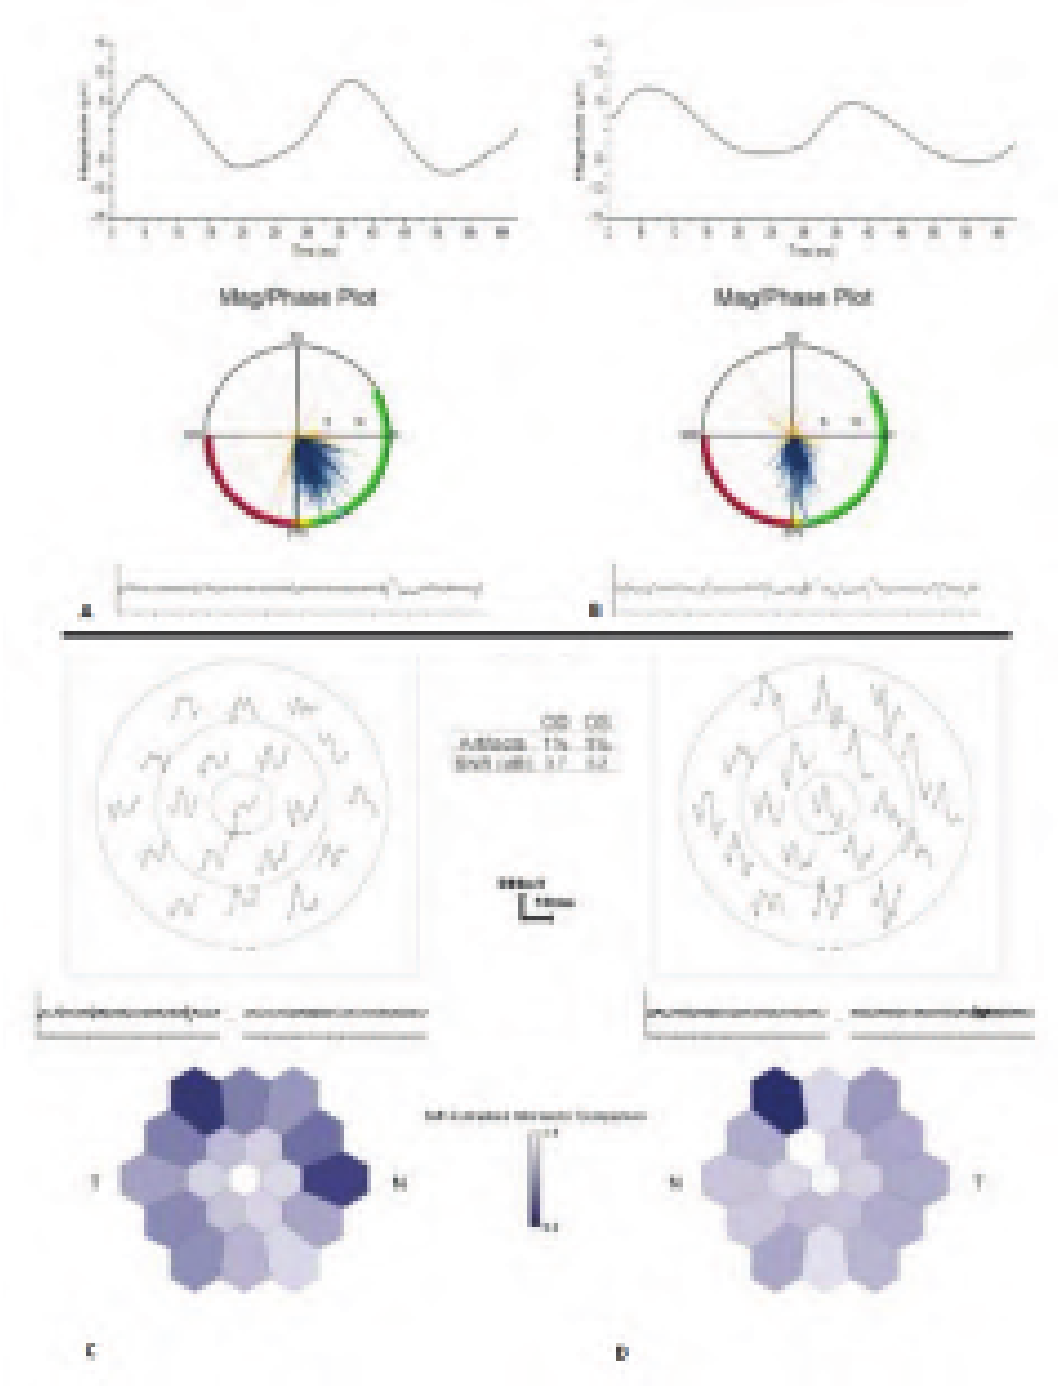
Figure 3. A and B illustrate fixed-luminance electroretinography (ERG) on Diopsys, which is equal to 30-Hz flicker conventional ERG. Waves have normal magnitude (amplitude) and phase (implicit time) in both eyes. Graphs show rays (blue lines) in the green area, which indicates a normal pattern. C and D show multifocal ERG of the right and left eyes, respectively. Multifocal ERG in both eyes is